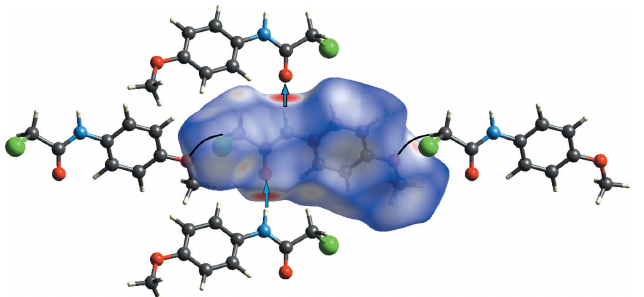
Figure 5 The Hirshfeld surface of the title molecule with two adjacent molecules involved in the N—H (cid:2)(cid:2)(cid:2) O, hydrogen bonded chain and two involving the C1—H1 A (cid:2)(cid:2)(cid:2) O2 hydrogen bonds. The former interaction is depicted by blue arrows and the latter by curved black lines.